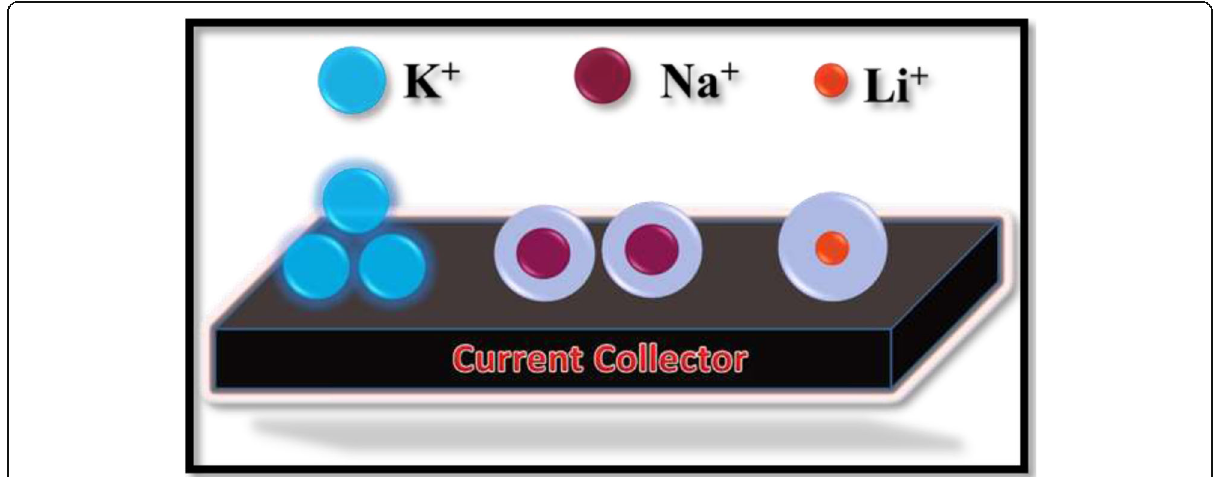
Fig. 7 Schematic diagram of hydrated ionic radii of the ions associated with different electrolytes used for GP10C electrode measurement